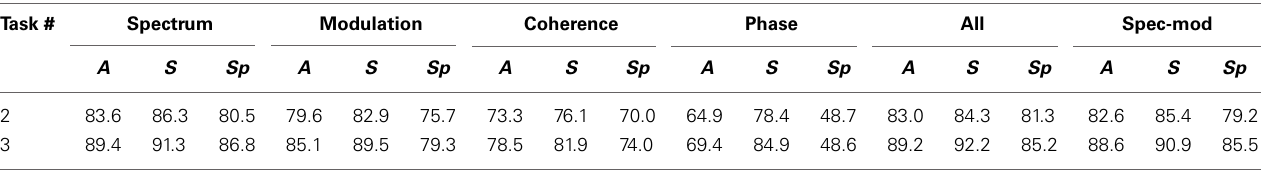
Table 2 | Baseline performance values for the two, 2-class tasks. Task # Spectrum